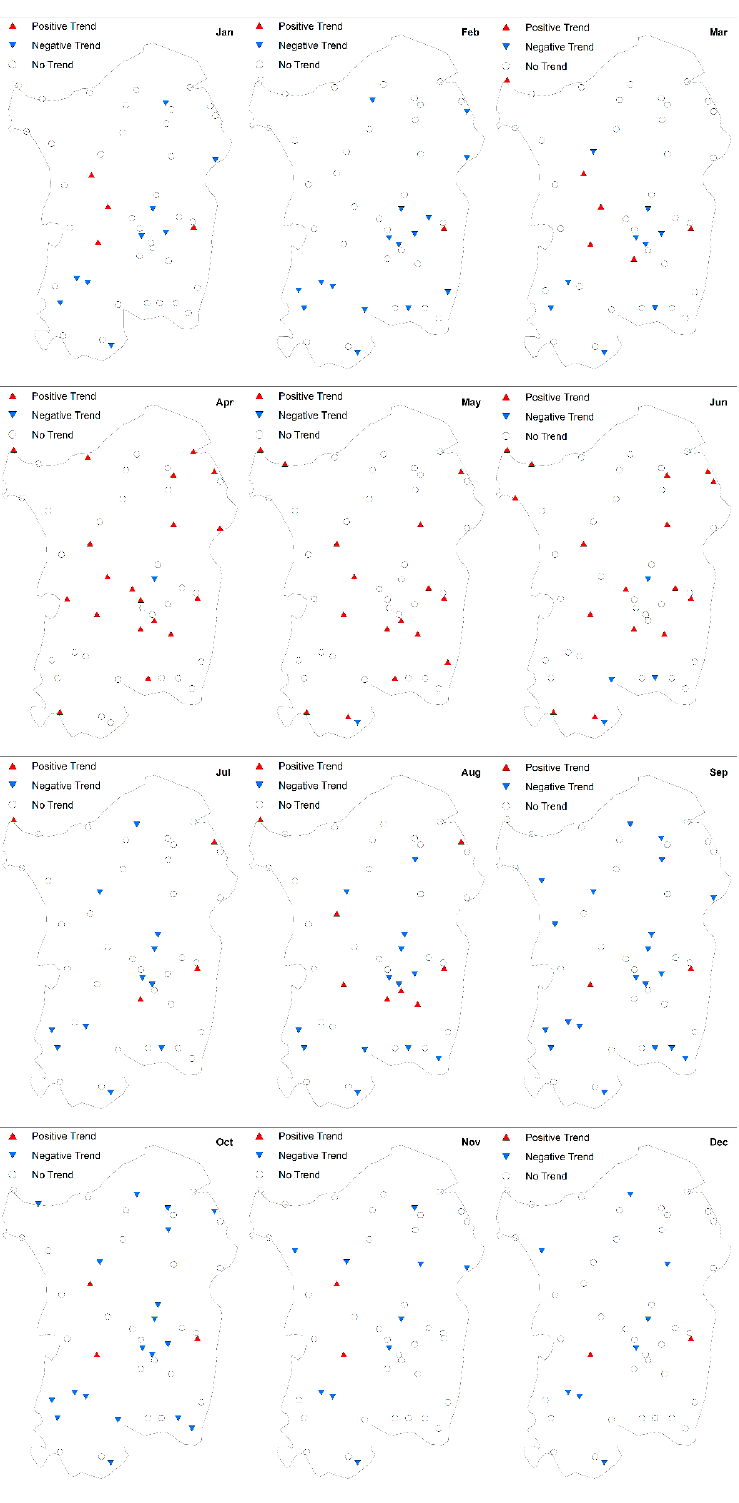
Figure 3. Spatial distribution of the monthly minimum temperature trend.